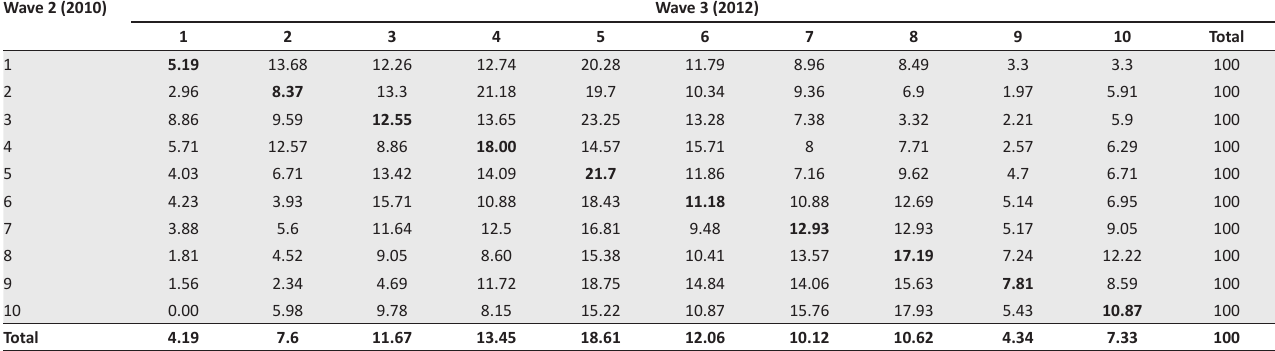
TABLE 2-A1: Subjective well-being transition dynamics, 2010–2012